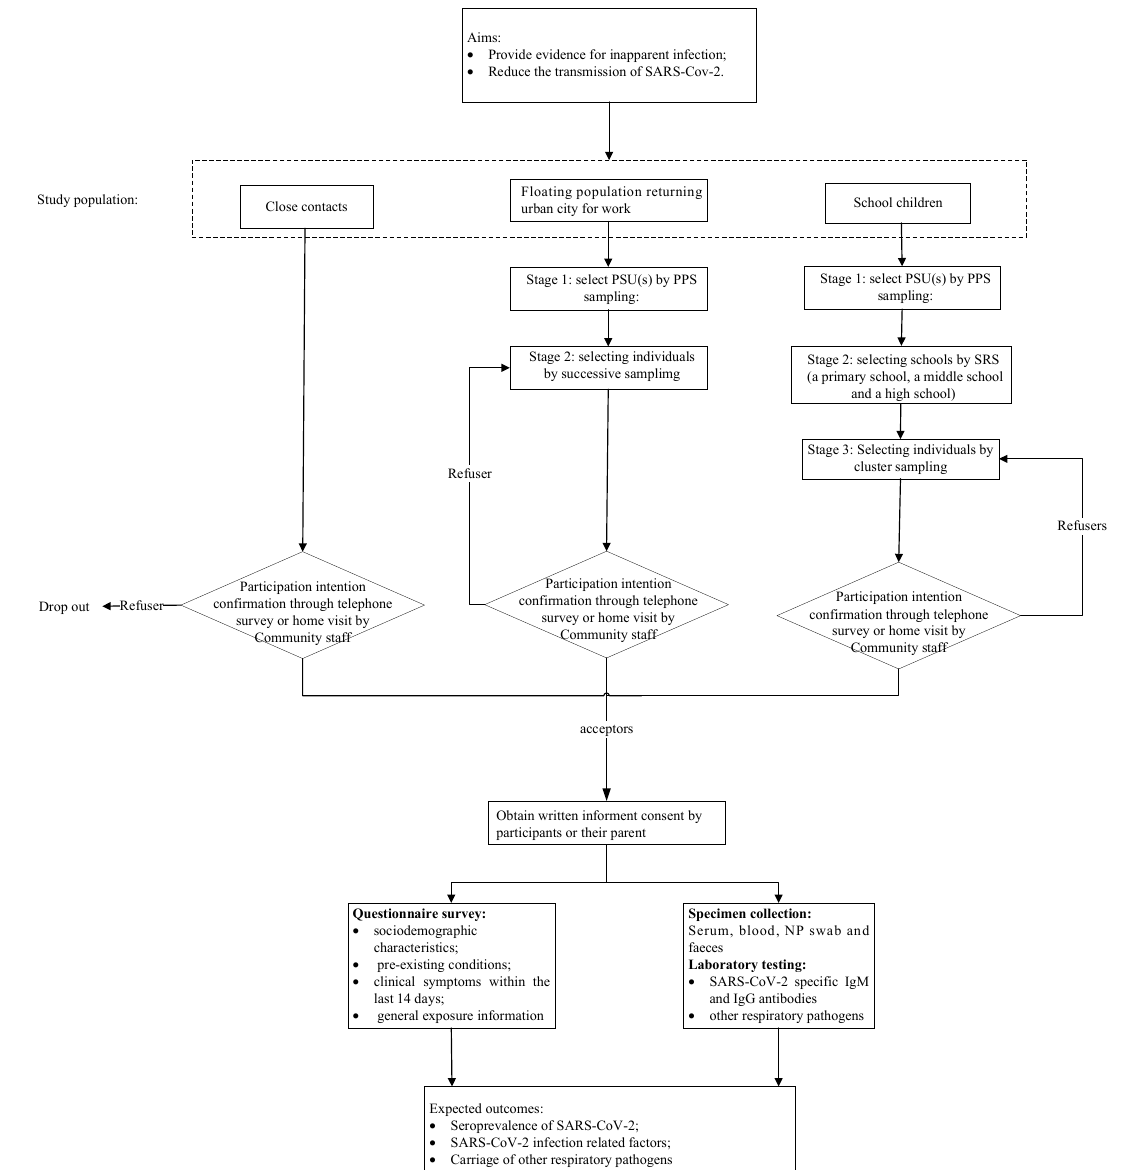
Figure 1. Study recruitment and data collection flow chart.